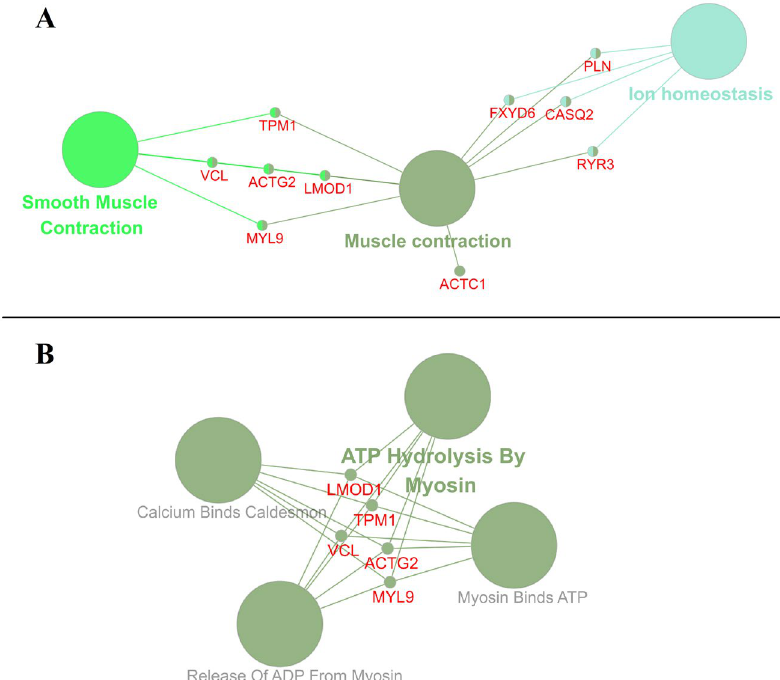
Figure 5. Enrichment of the major Reactome pathways and reactions. The figure represents the Enrichment of the Reactome pathways ( A ) and reactions ( B ) associated with the 126 salient genes (Labeled in red colour). Node size is inversely proportional to the p-value, i.e., the lower the p-value, the bigger the node size and colour represents a different group of terms.